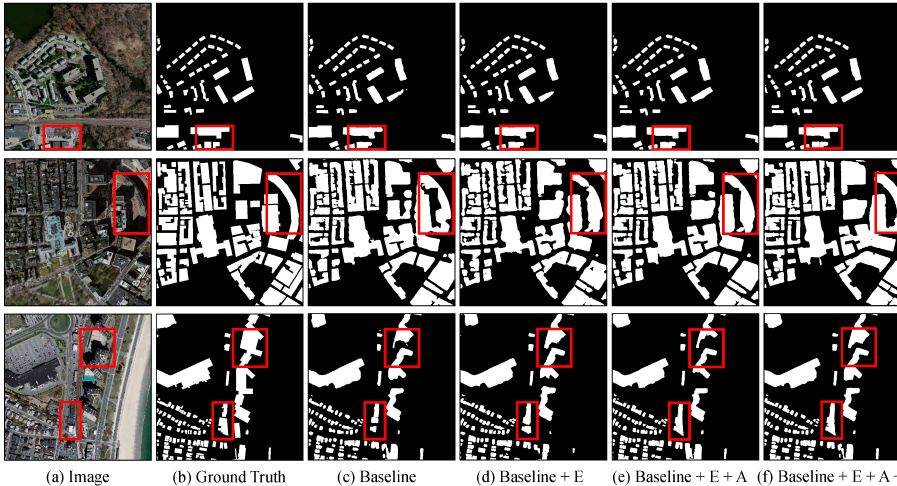
Figure 11. Ablation study results using the Massachusetts dataset.